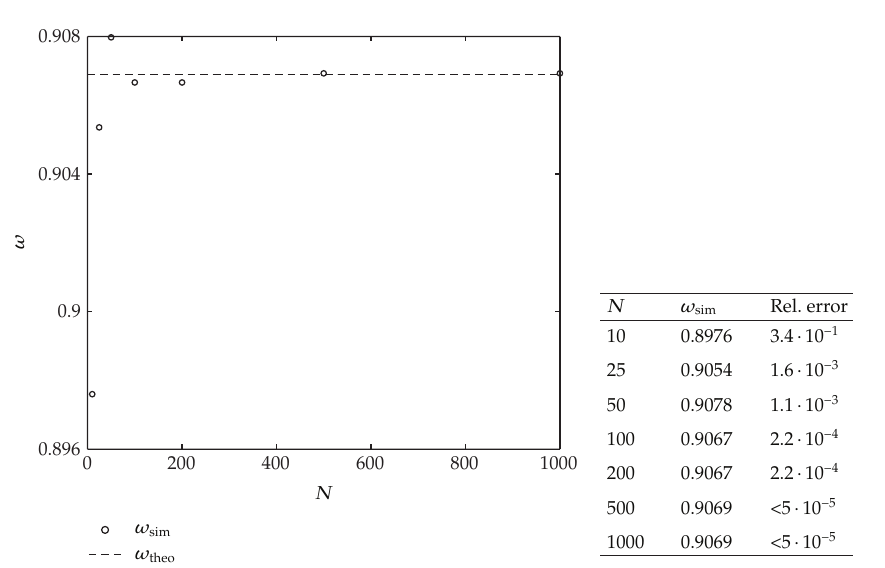
Figure 2: Torsional oscillation-Frequency ω versus number of grid cells N